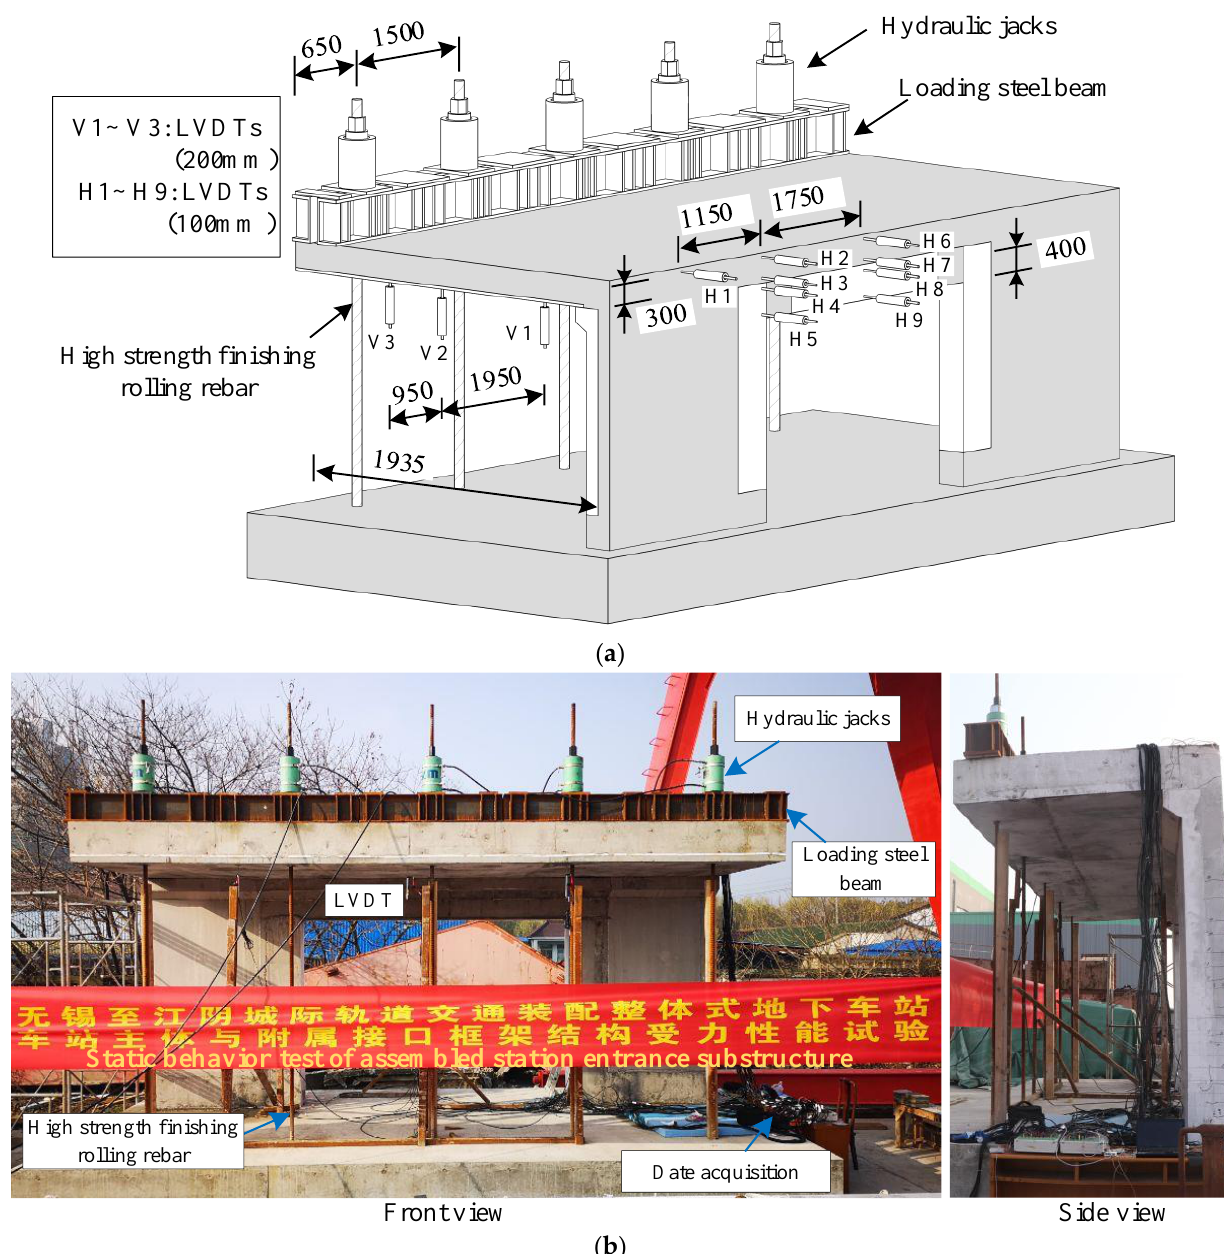
Figure 6. General overview of a test setup (units: mm): ( a ) schematic of the test setup and ( b ) photograph of the test setup.